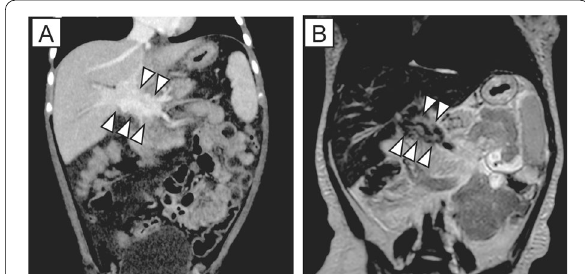
Fig. 1 Contrast-enhanced computed tomography and magnetic resonance images obtained at admission. A Contrast-enhanced computed tomography (coronal reconstructed multiplanar image) revealing a large hypervascular tumor arising from the hepatoduodenal ligament (HDL) (arrowheads). B Coronal T2-weighted image showing a mass-like lesion with a low-intensity area along the